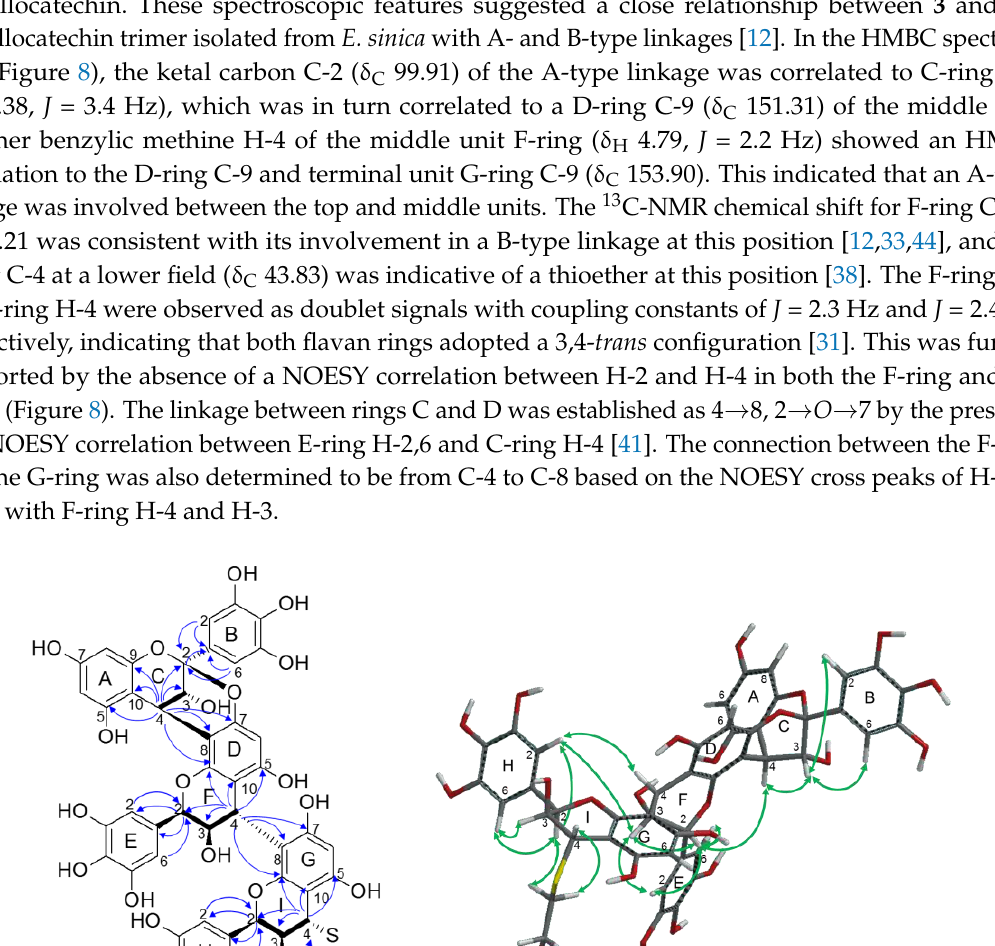
( b ) (−)-epigallocatechin-(+)-epigallocatechin-(−)- epigallocatechin, ( c ) (−)-epigallocatechin-(−)-epigallocatechin-(+)-epigallocatechin, and ( d ) (−)- epigallocatechin-(+)-epigallocatechin, and ( d ) ( − epigallocatechin-(+)-epigallocatechin-(+)-epigallocatechin (Figure 9). The experimental ECD